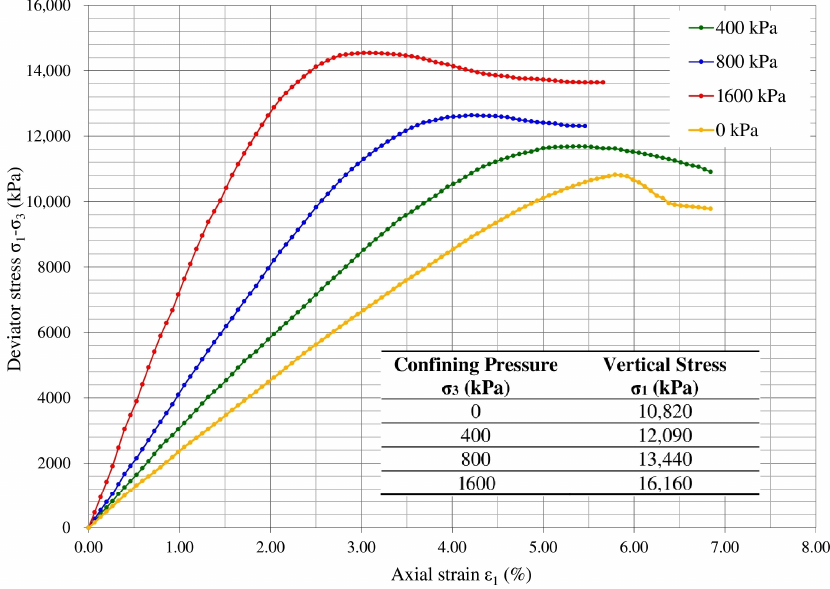
Figure 15. Results of triaxial compression tests of coal.